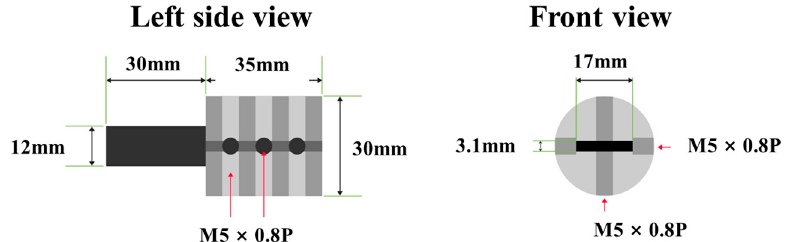
Figure 8. Left and front view of Nuss bar jig design. Designed jig is holding metal bar during the production process of patient-specific Nuss bar by CNC bending machine.